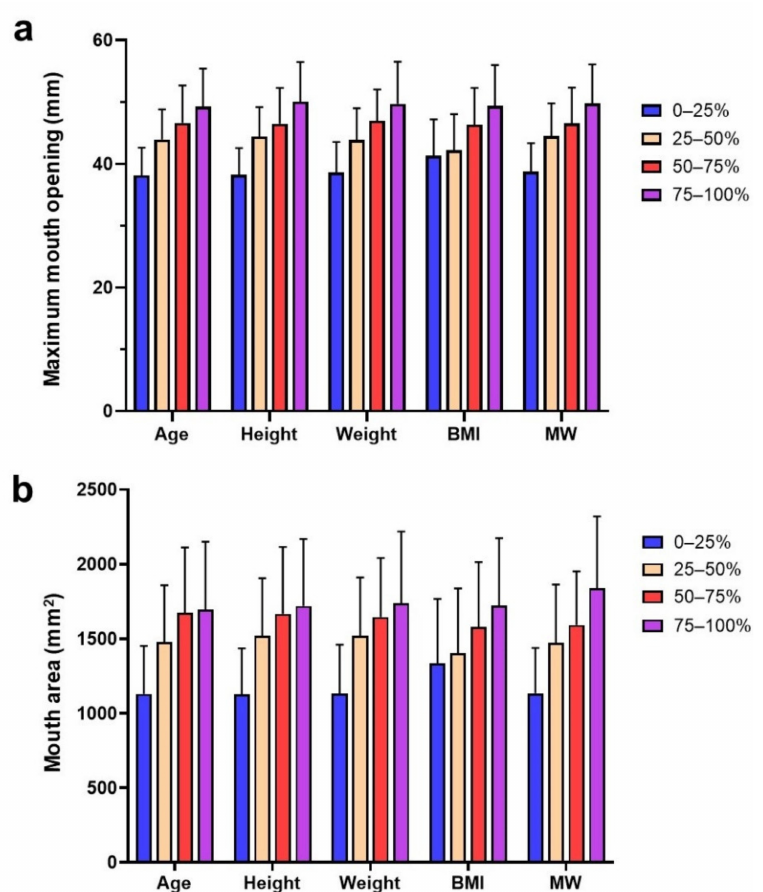
Figure 3. Range distributions of maximum mouth opening ( a ) and mouth area ( b ) in quartile groups according to the studied age, height, weight, body mass index and mouth width. BMI, body mass index; MW, mouth